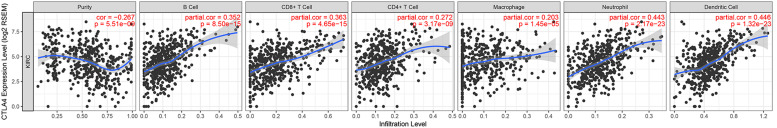
Correlation of CTLA4 expression with immune infiltration level in ccRCC.